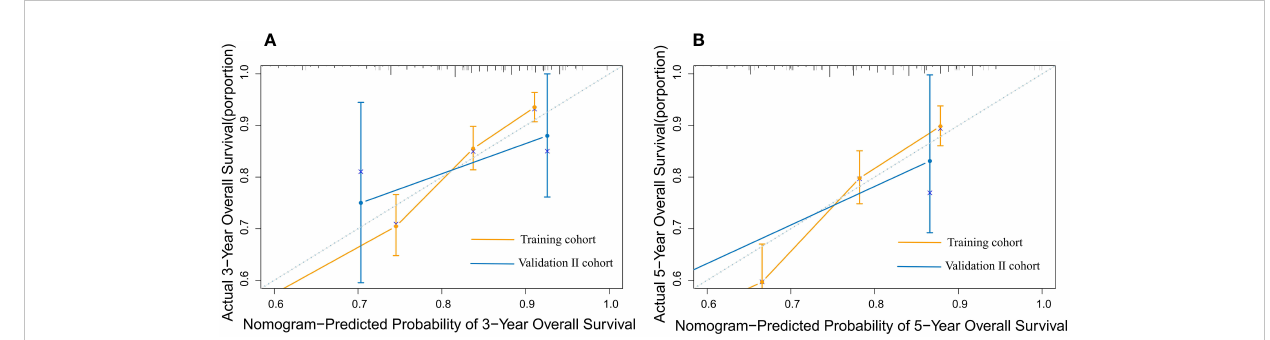
FIGURE 7 The calibration plot for predicting 3- and 5-year overall survival for patients with MBC. Calibration plot of nomogram prediction of (A) 3-year and (B) 5-year OS of patients with MBC in the training and validation II sets.